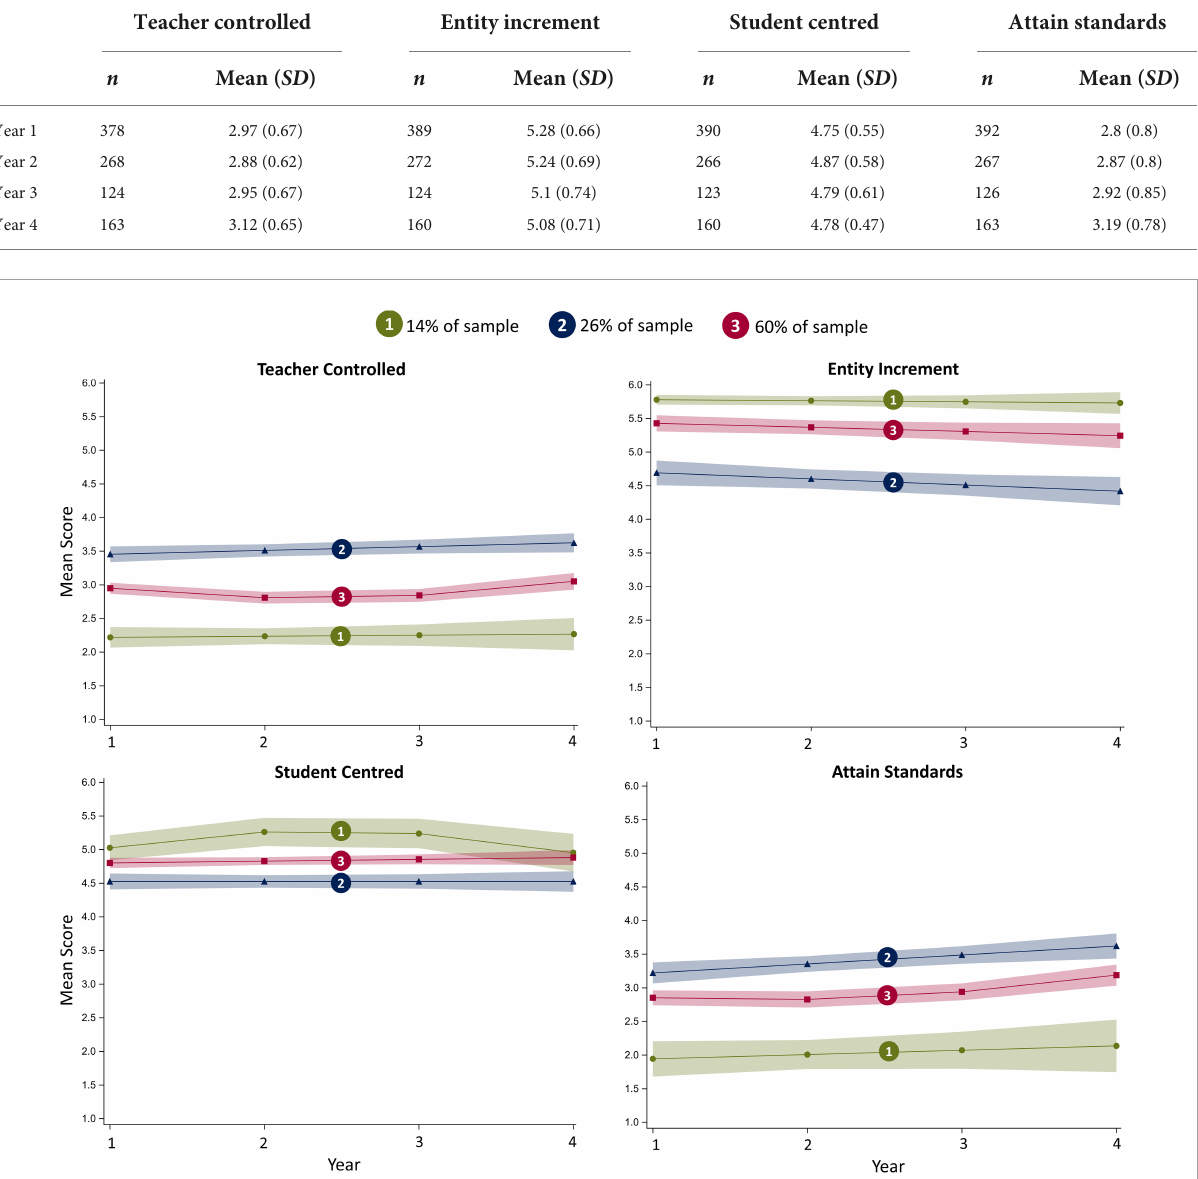
TABLE 1 Sample size, mean, and standard deviation (SD) at each time point.